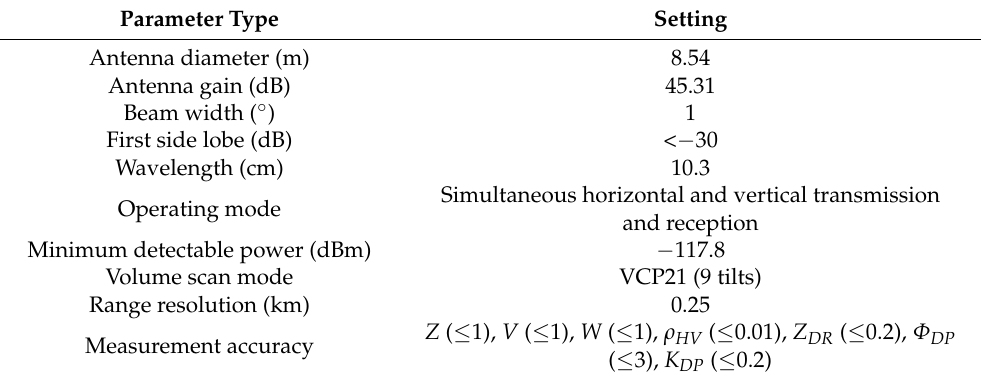
Table 1. Main specifications of S-band dual-polarization radar. Parameter Type Setting